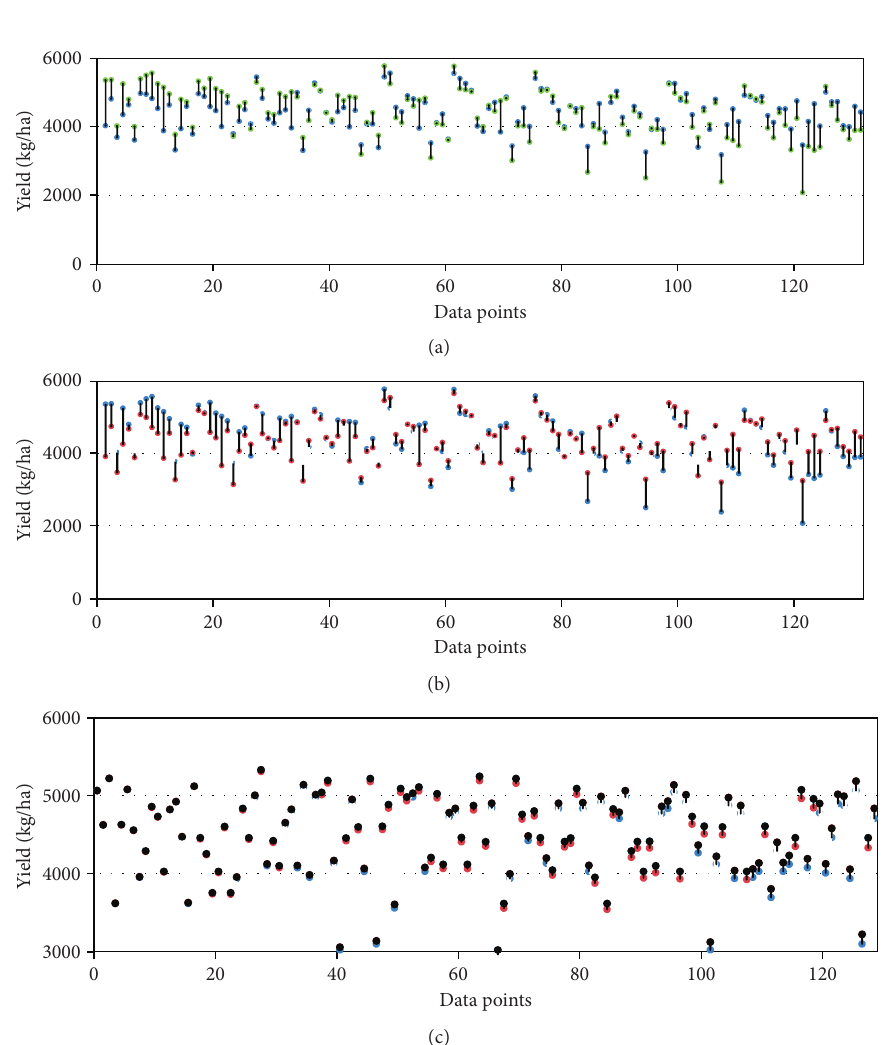
Figure 5: Error of the yield predicted by applying regression techniques: (a) MLR (stepwise), (b) PR, and (c)